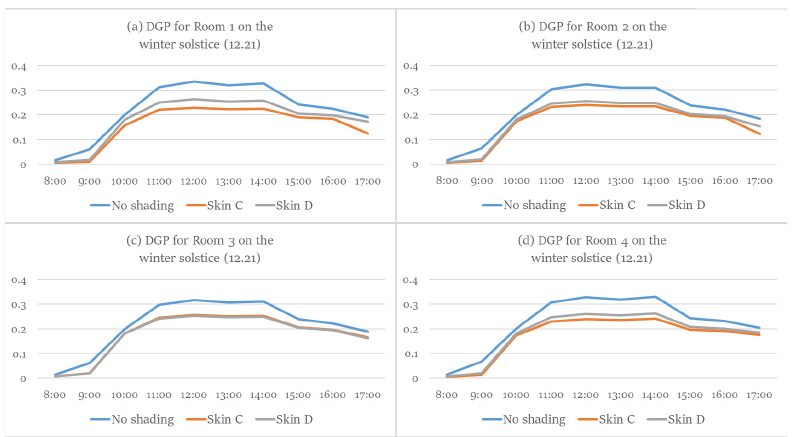
Figure 20. DGP for ( a ) Room 1, ( b ) Room 2, ( c ) Room 3, and ( d ) and Room 4 on the winter solstice (12.21) (self-developed).